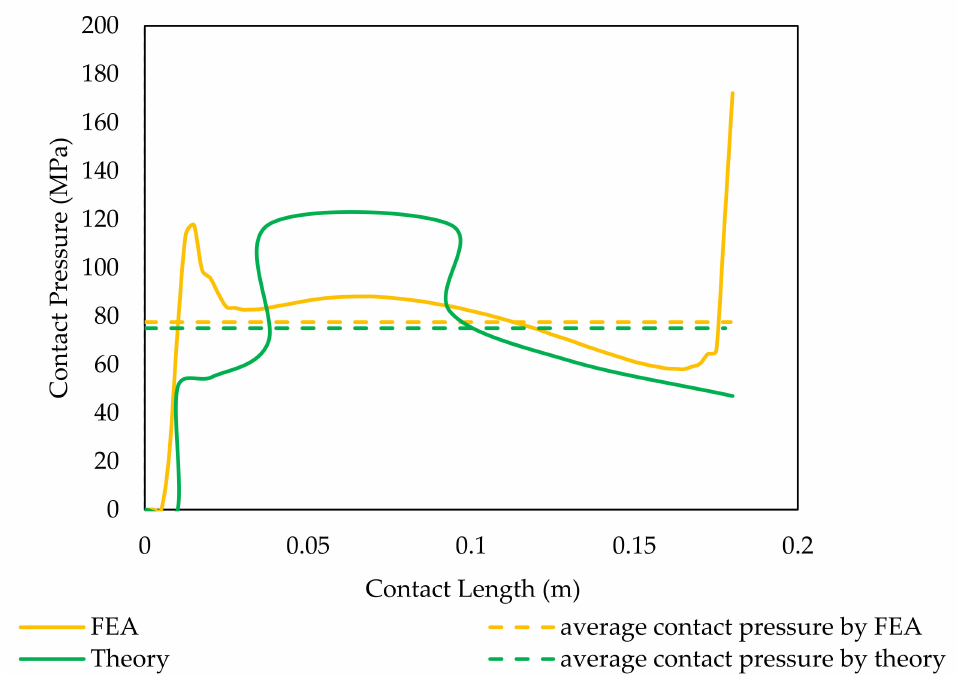
Figure 8. Contact pressure distribution along the contact